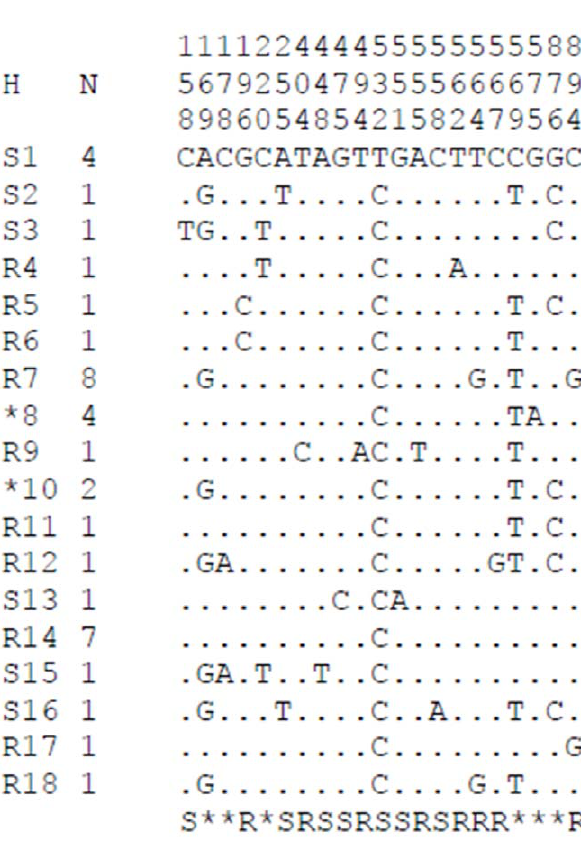
N, number of sequences (2n); H, number of haplotypes (with 2 haplotypes in common); S, number of polymorphic sites; Ts, transition substitution; Tv, transversion substitution; F, frequency of the most common haplotype; h, Number of haplotypes (haplotype diversity); p , nucleotide diversity (k=mean number of